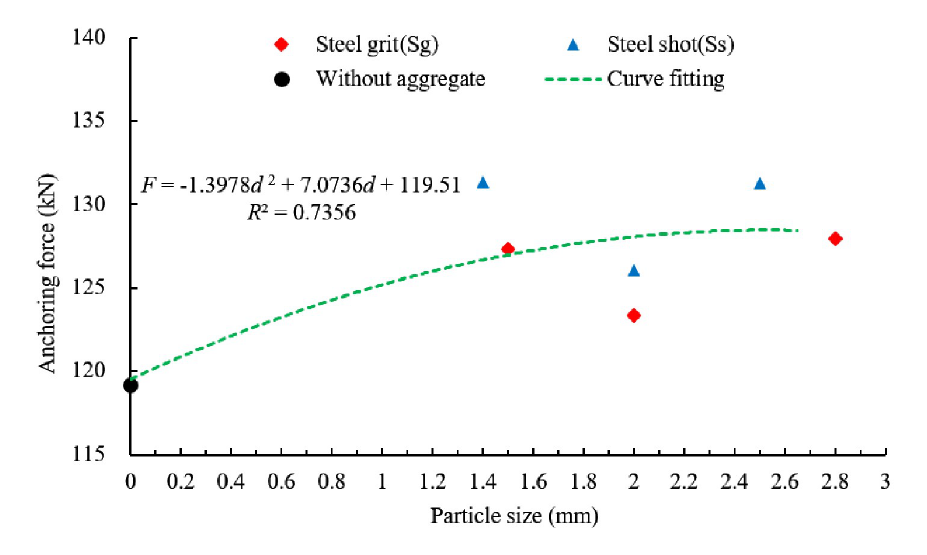
Fig 18. Scatter plot of average anchoring force and fitting curve of different aggregate